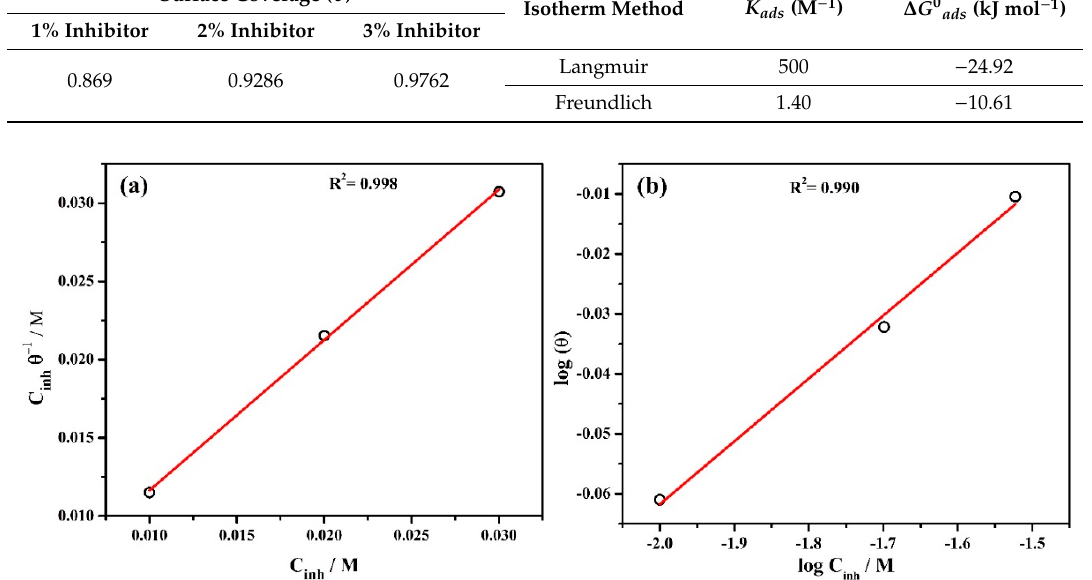
Figure 2. Inhibitor adsorption isotherm ( a ) Langmuir and ( b ) Freundlich at 20 °C.